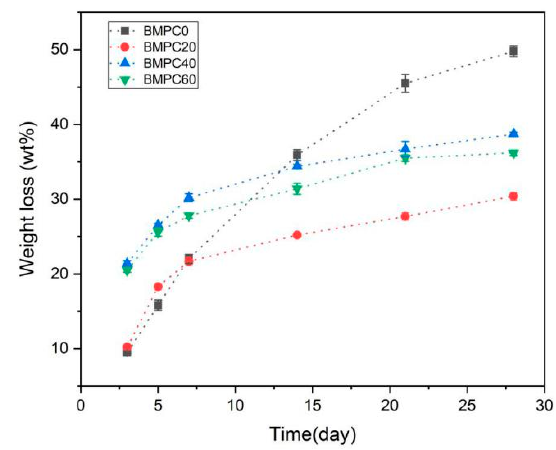
Figure 6. The degradation rate of BMPC samples with Ca(H 2 PO 4 ) 2 .